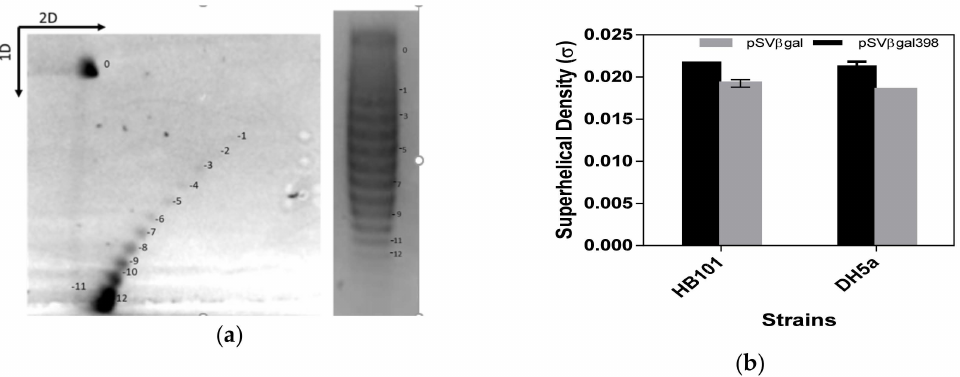
Figure 3. Superhelical density determination of plasmid amplified in DH5 α and HB101. ( a ) 2D and 1D chloroquine-agarose gel electrophoresis showing the distribution of topoisomers of the plasmid. The bands depict the linking di ff erence which is then used to calculate the superhelical density ( b ) Chart showing the superhelical density of pSV β -gal398 and pSV β -gal amplified in the two strains. N = 4. The di ff erence observed is statistically significant in the two strains ( p <